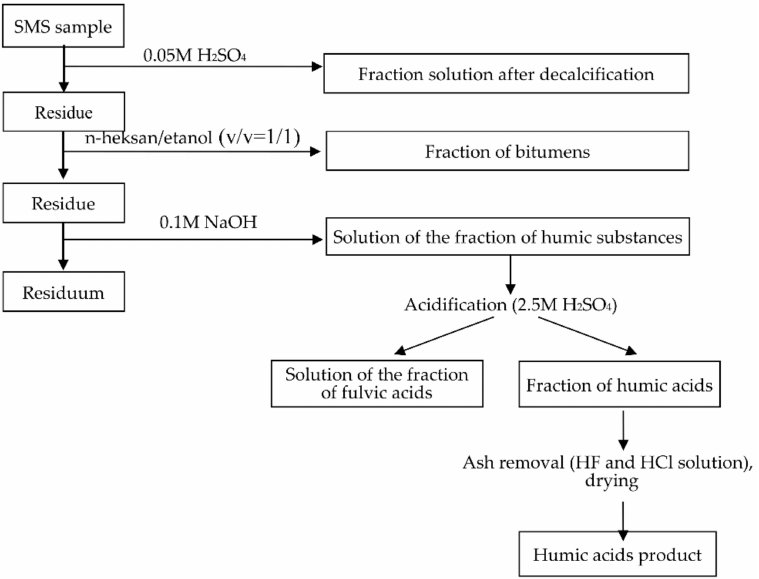
Scheme 1. Diagram of sequential fractioning of the organic matter under